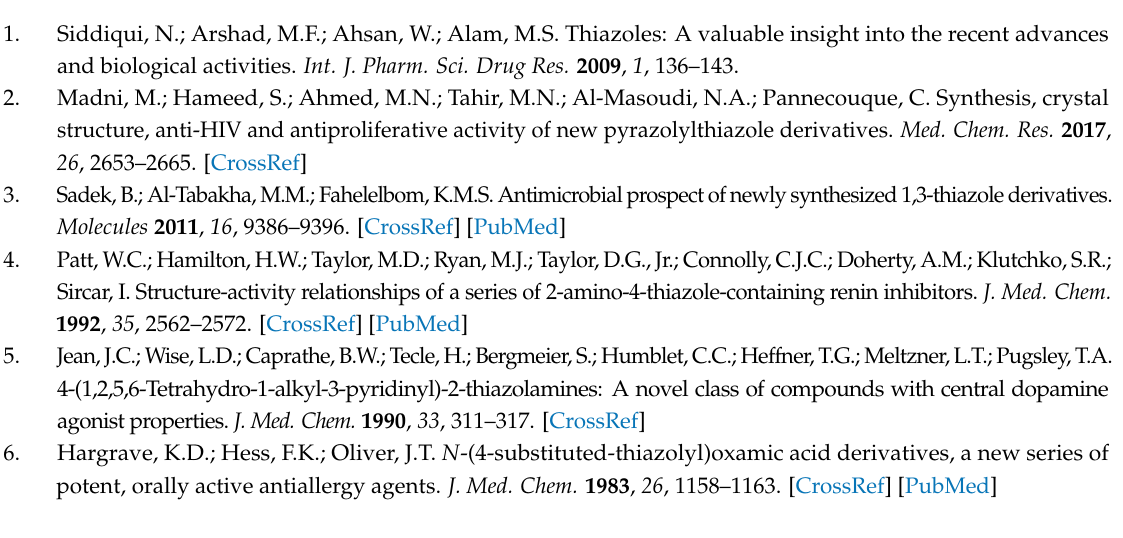
Figure S3: IR spectrum of the synthesized compound 5 , Figure S4: Mass spectrum of the synthesized compound 5